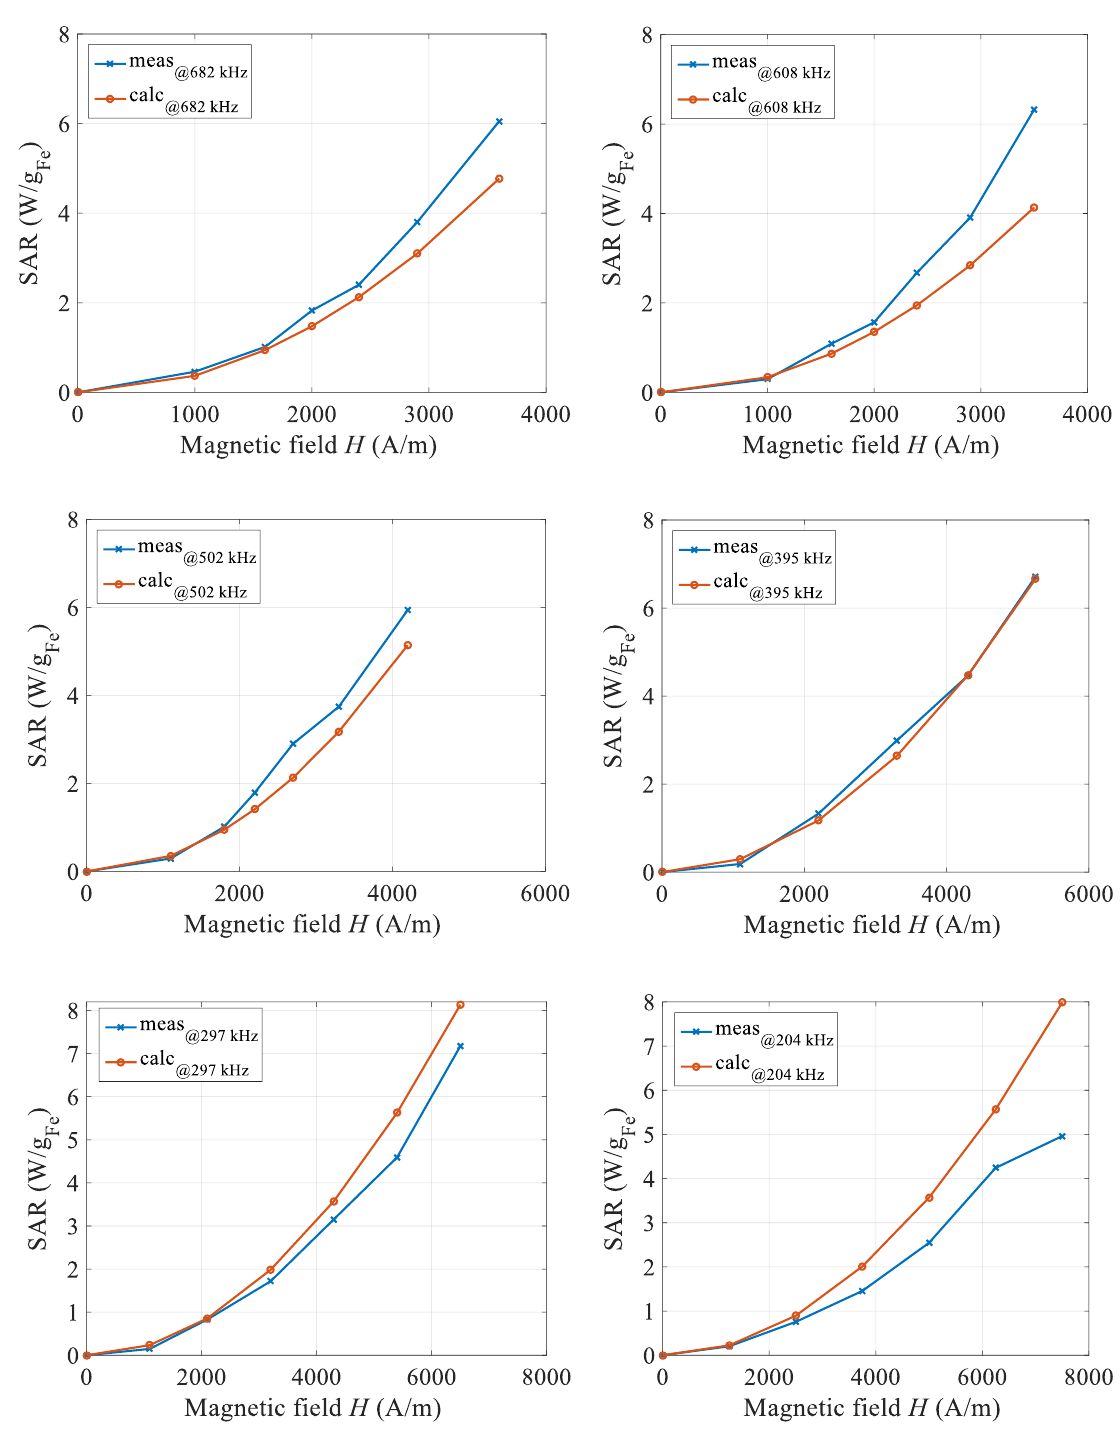
Figure 8. Comparison of measured and calculated SAR curves for six different frequencies of the magnetic field.